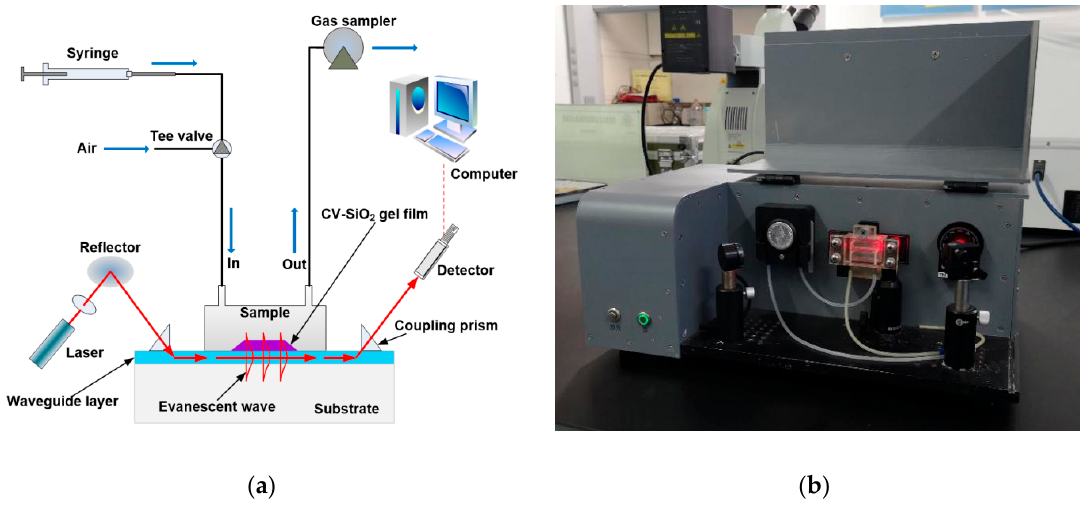
Scheme 2. Schematic diagram of the OWG sensor ( a ) and photography of the sensor ( b ).